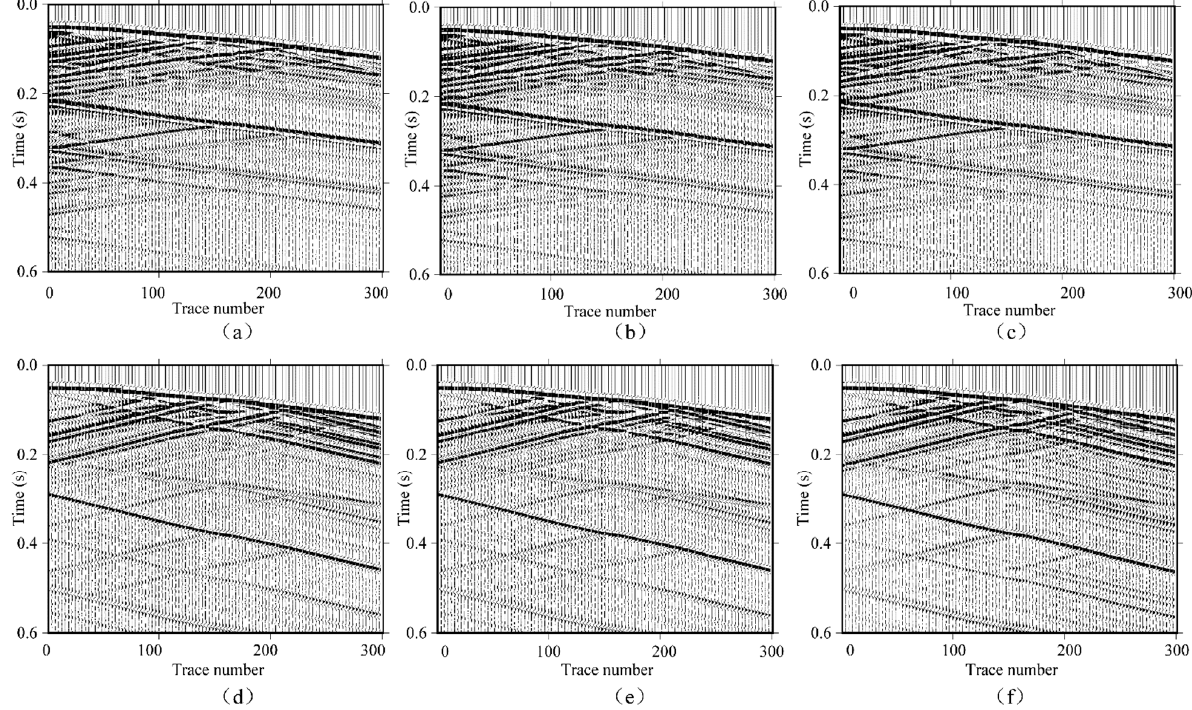
Figure 2. ( a – c ) The vertical component of the time-lapse cross-well shot gather with the shallow source position (400 m) from the baseline survey, first-repeat, and second-repeat surveys, respectively. ( d – f ) as in ( a – c ) but displaying the horizontal components instead.